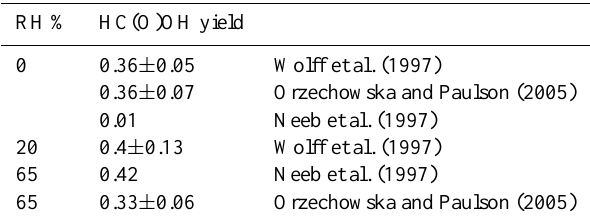
Table 1. Formic acid yields previously reported, to the best of our